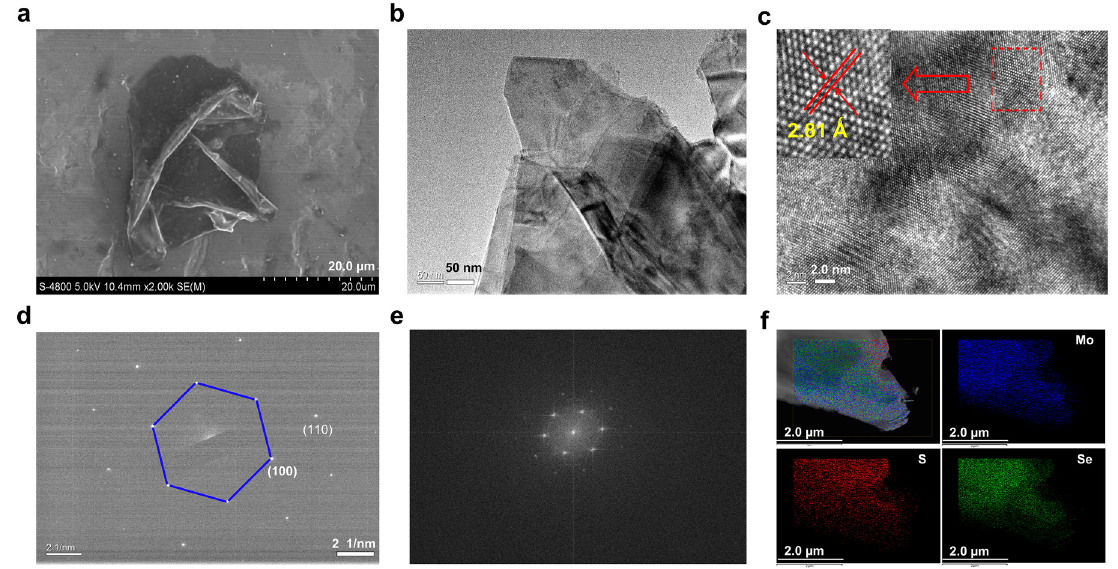
Figure 3: The morphology of sample. (a) SEM image of the surface of deposited MoS 0.5 Se 1.5 alloy nanosheets. (b) Low and (c) high resolution TEM of MoS 0.5 Se 1.5 alloy fi lm, inset is the magni fi ed crystal structure view of selected red box in (c). (d) The corresponding SAED patterns and (e) FFT image. (f) EDS elemental mapping of Mo, S and